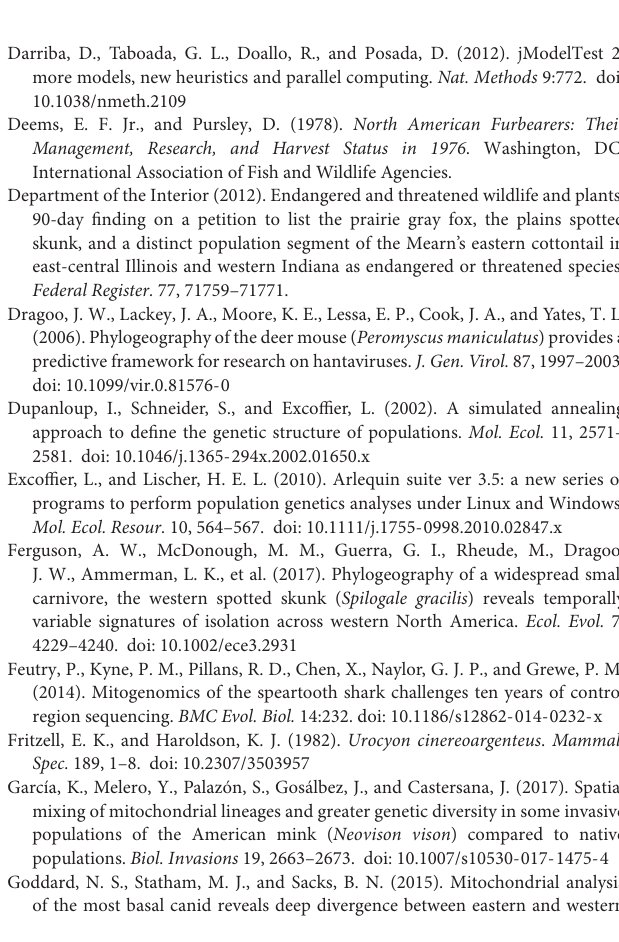
Supplementary Figure 1 | Geographic pattern of nucleotide diversity for 31 Urocyon sample groups ( n > 10) based on 400 bp of mtDNA control region. (A) Circles are located at the geographic mean center of each sample group and size reflects the quantile of the nucleotide diversity value. (B) Linear regression of nucleotide diversity by latitude for East and West sample groups. Supplementary Figure 2 | Matrix of pairwise F ST values (K2P-corrected) between Urocyon sample groups ( n = 34) based on 400 bp of mtDNA control region.